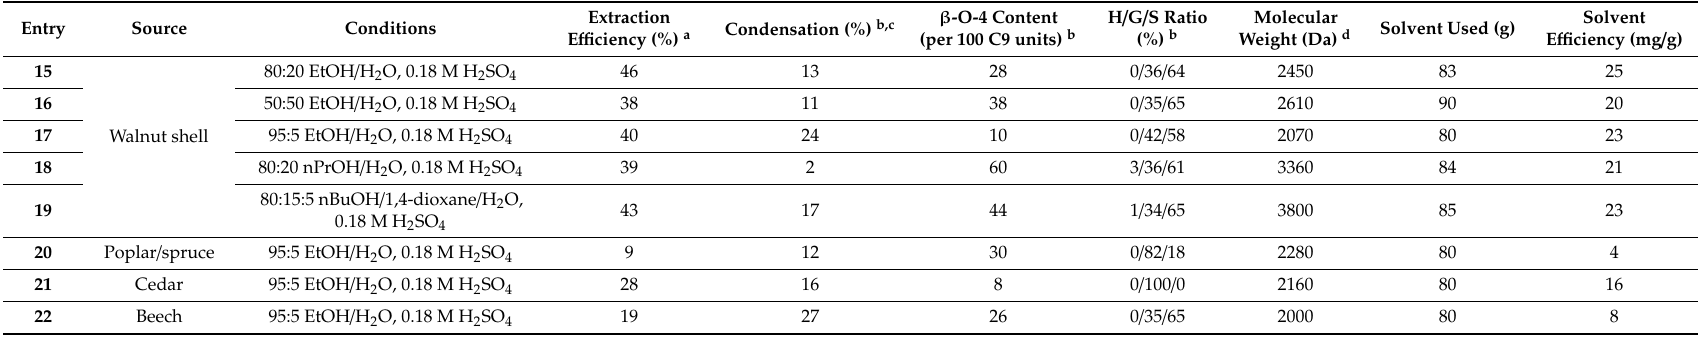
Table A2. Overview of extraction e ffi ciencies and lignin properties of all extractions performed in batch setup. a Corrected for alcohol incorporation determined